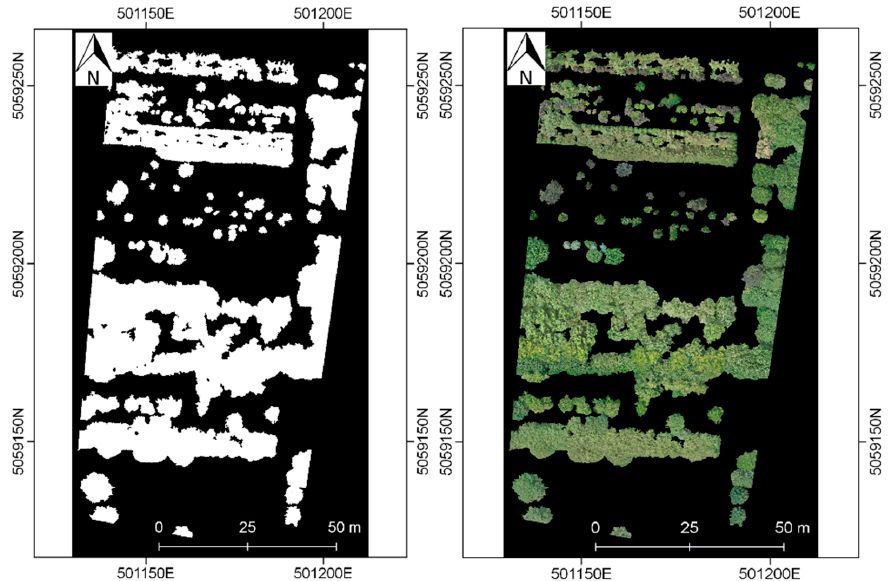
Figure 11. The mask ( left ) and the masked RGB_S orthophoto ( right ).